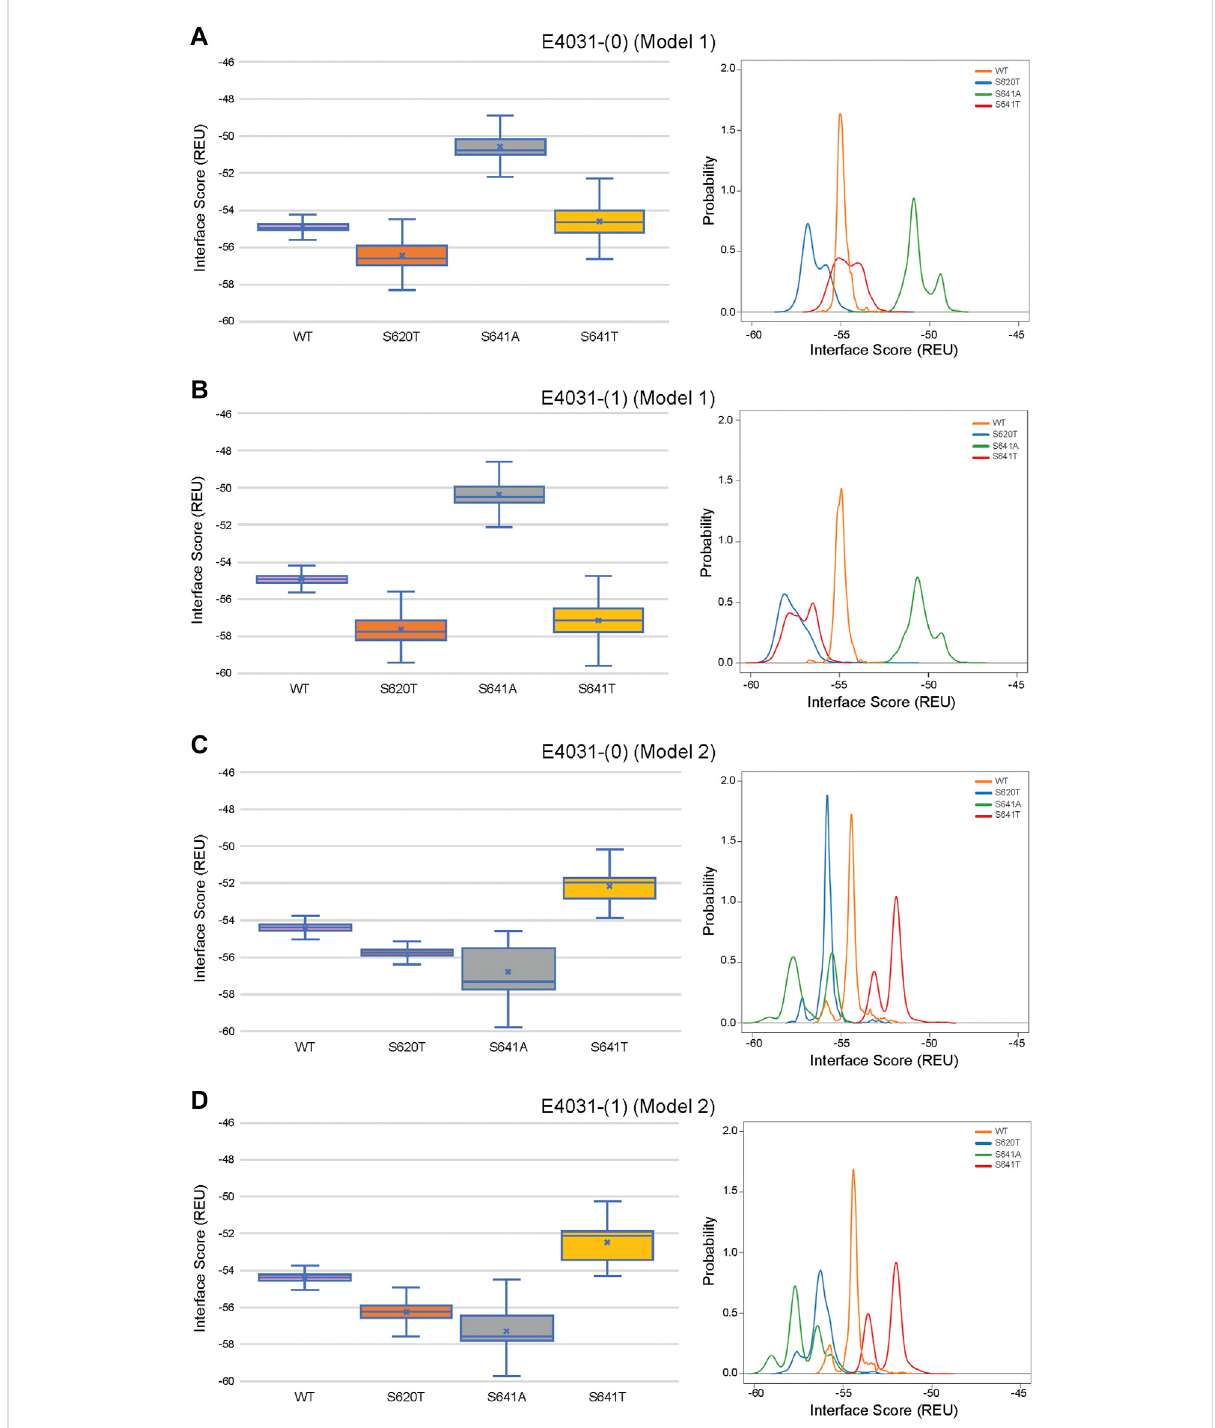
FIGURE 12 Interface score distributions for hERG channel interactions with dofetilide. Left Panels: Box-and-whisker plots of interface scores in REU. Right Panels: Probability density charts plotting probability density against interface scores (REU). All plots utilize 2,000 generated structures. Plots are de fi nedfor (A) neutral(0)model1, (B) charged(1)model1, (C) neutral(0)model2and (D) charged(1)model2structures.ErrorbarsrepresentMaxand Min values; Mean (x); Median (horizontal